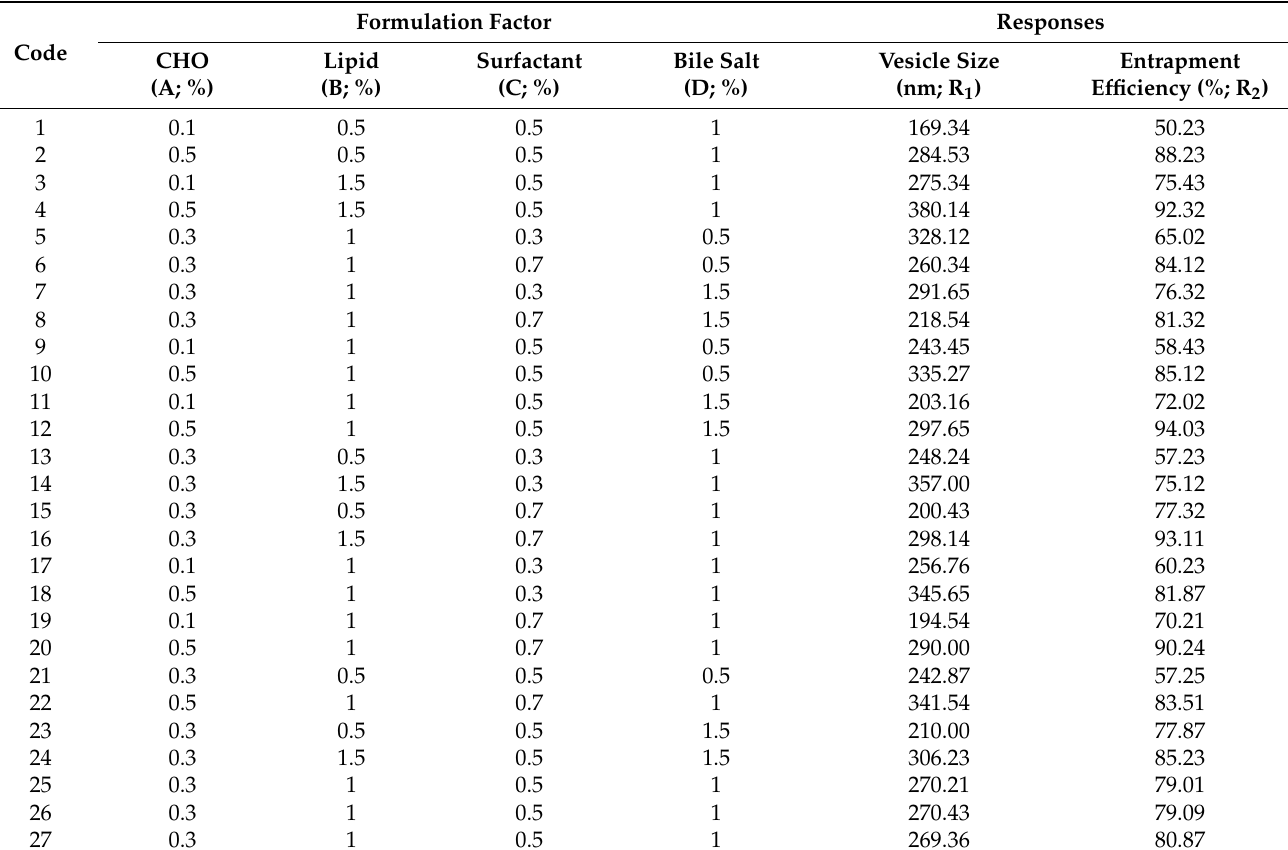
Table 1. Formulation composition and their effect on vesicle size and entrapment